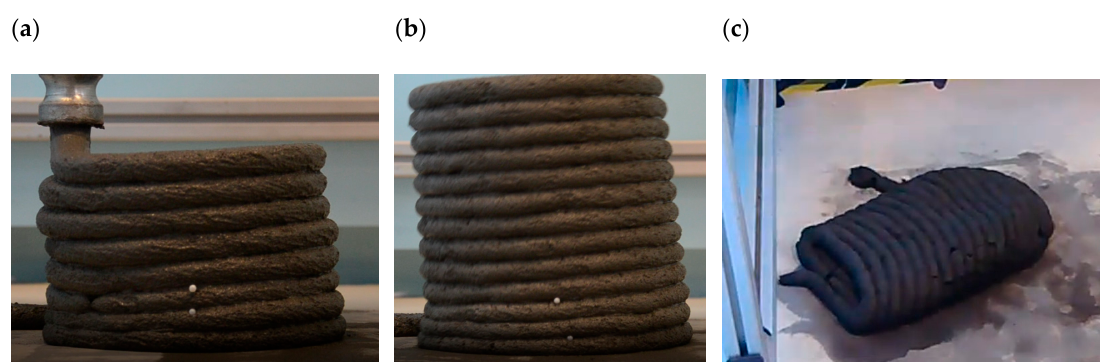
Figure 15. Collapse during printing for specimens of mix B640 / SF / FA / LP. ( a ) t b = 15 min; t p = 10 s; ( b ) t b = 30 min; t p = 15 s; ( c ) t b = 45 min; t p = 20 s.